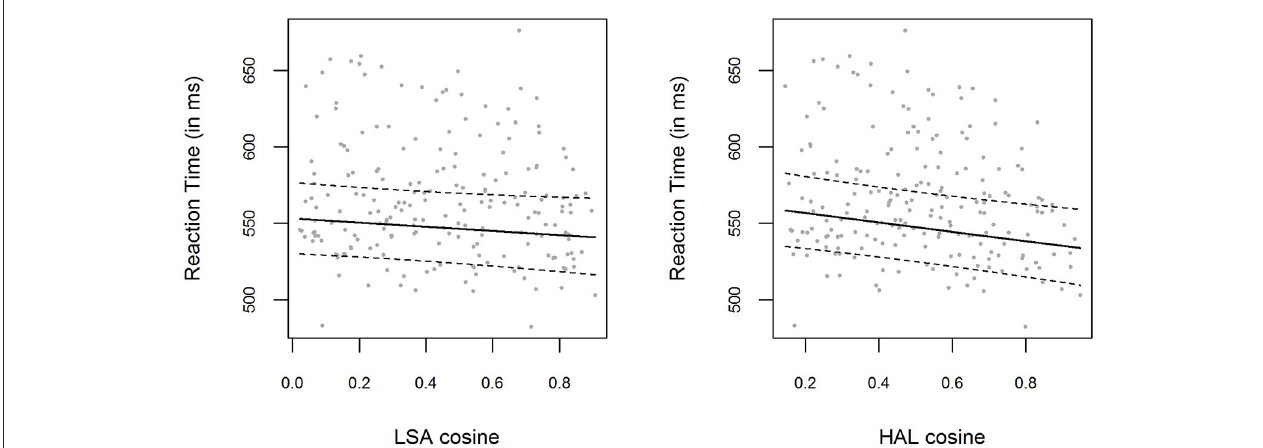
FIGURE 1 | (Left panel) Mean RTs for each item in Experiment 1, plotted as a function of the prime-target LSA cosine similarity. The solid line shows the exponentiated model predictions of the model including cosine fixed effects, with the corresponding 0.95 confidence interval (dashed line). (Right panel) Mean RTs and model predictions, as in the left panel, for HAL cosine similarities.